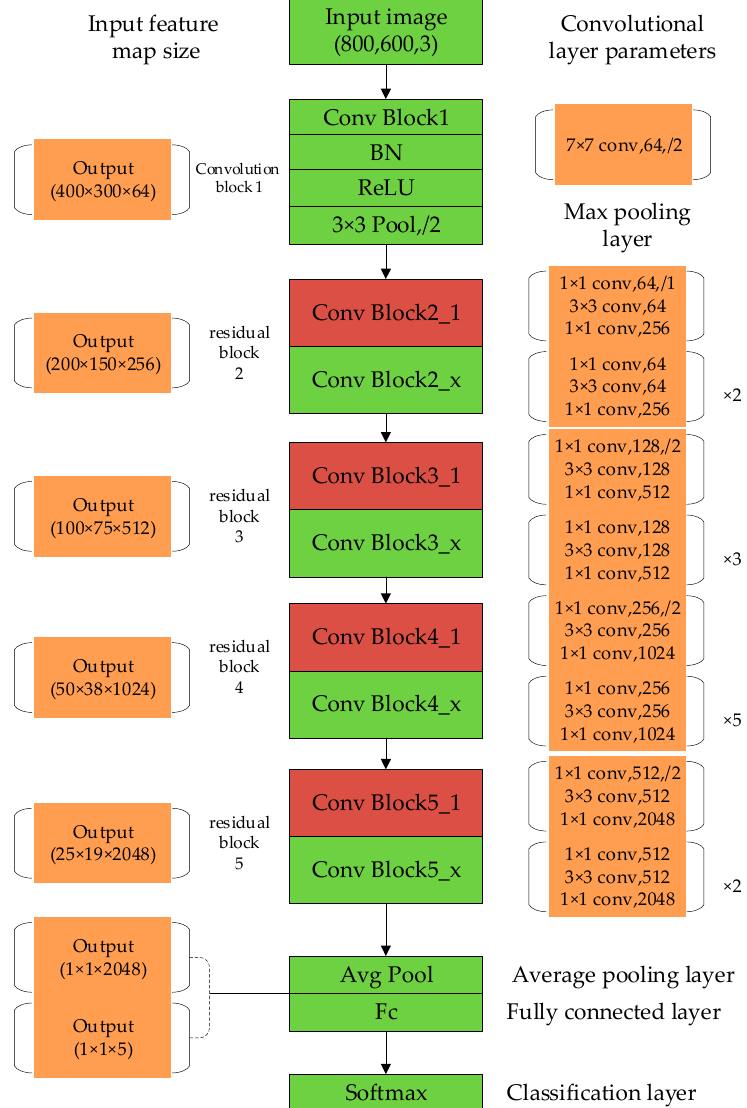
Figure 7. ResNet50 model network structure.